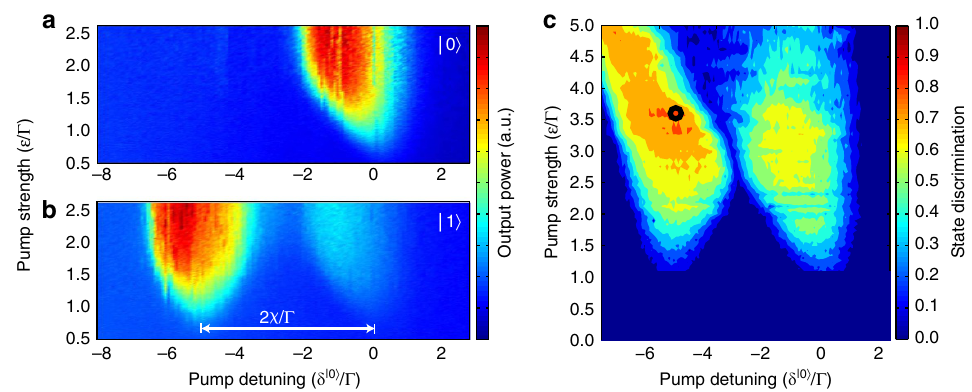
Figure 4 | Parametric oscillations and state discrimination. Output field of the resonator when the qubit is in its ( a ) ground state |0 i and ( b ) excited state |1 i . ( c ) Contour plot of the state discrimination within the two parametric oscillation regions. The black circle in the left region, located at d |0 i / G ¼ (cid:2) 5.34, E = G ¼ 3 : 56, represents the bias point used throughout the rest of the analysis. The state discrimination in this point is 81.5%.